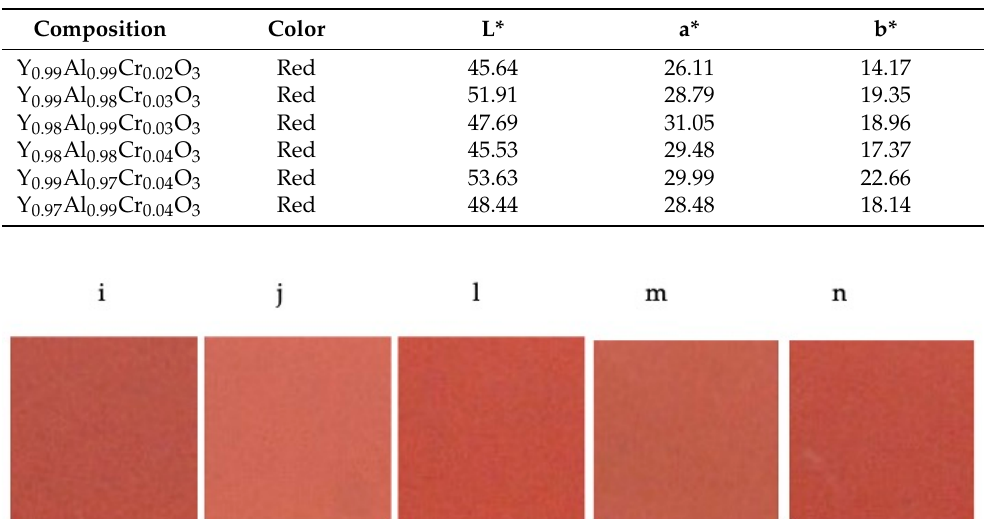
Table 3. Chromatic coordinates values of glazed tiles in the Y 1 − x Al 1 − y Cr x+y O 3 system.